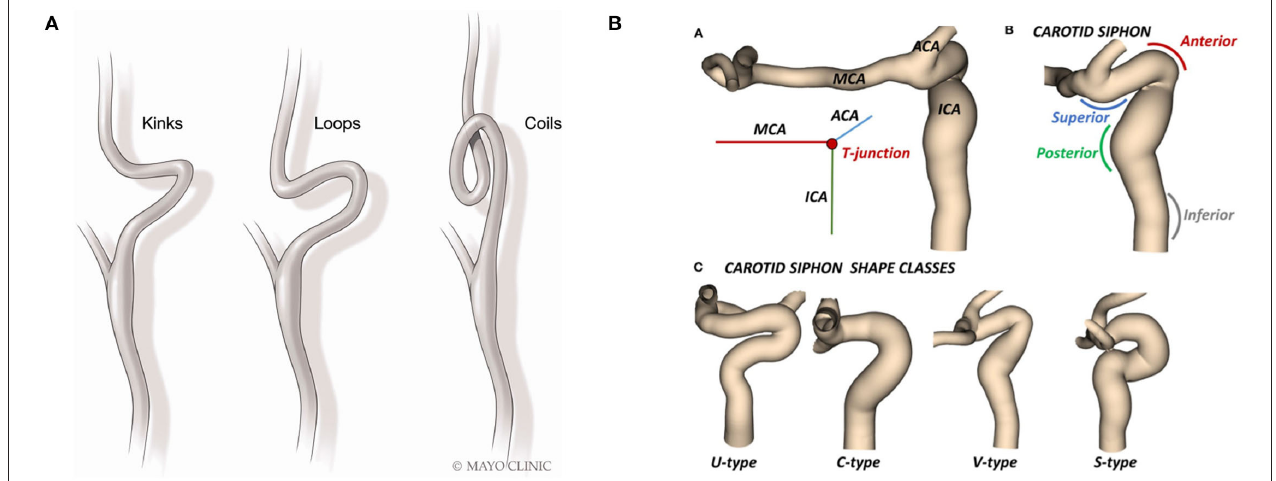
FIGURE 3 | Illustrations of anatomical tortuosity in (A) the ICA and (B) the carotid siphon. Reproduced from (56, 57) with